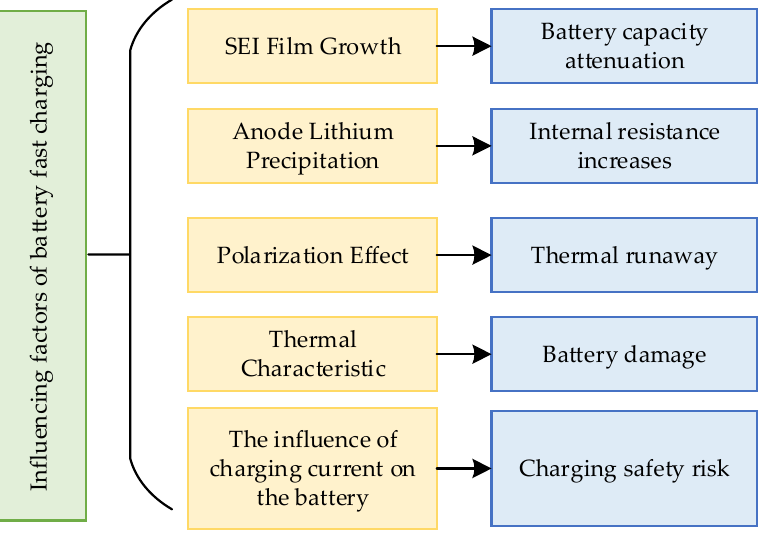
Figure 21. Factors in fl uencing fast charging of power ba tt eries.